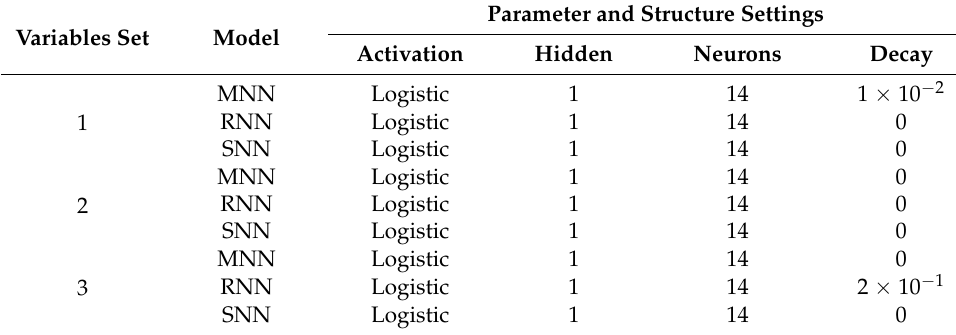
Table 6. Optimal parameter settings for the models.